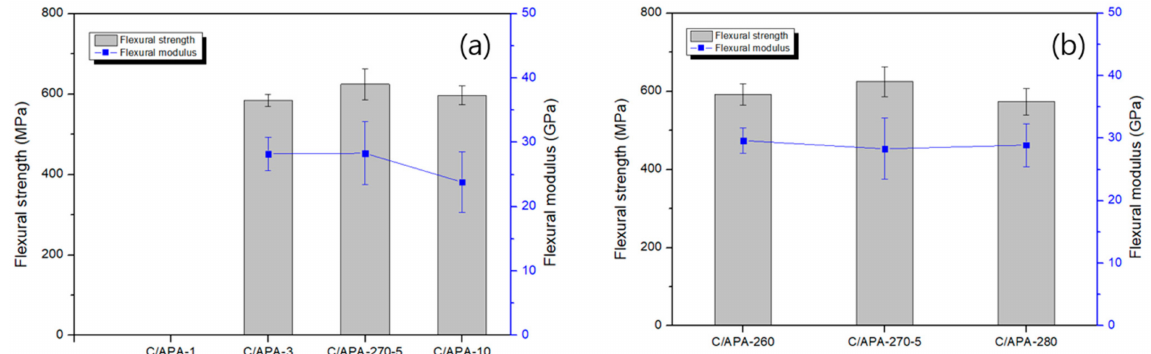
Figure 9. Flexural strength and modulus of Carbon/APA manufactured under different molding conditions: ( a ) molding time and ( b ) molding